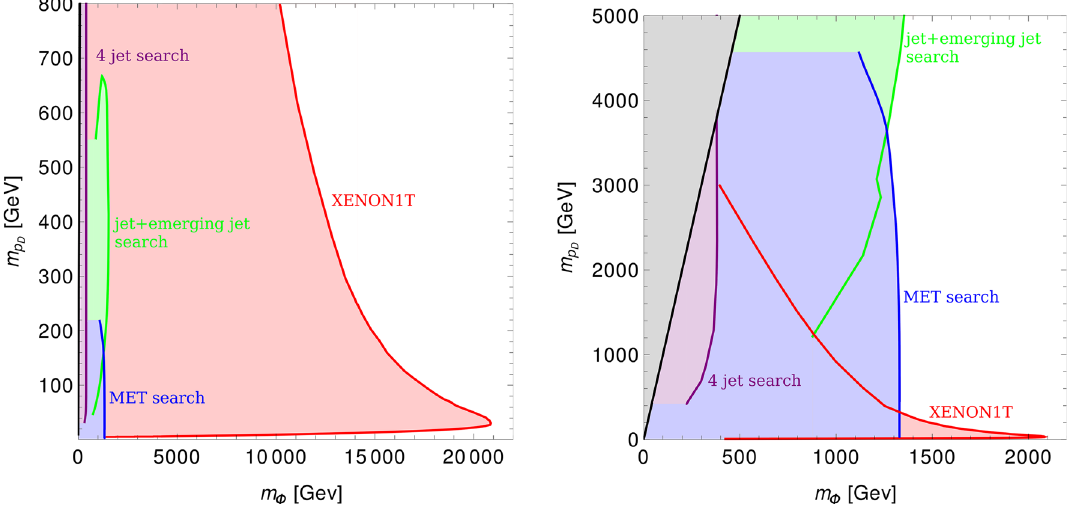
= 10 m π . Left: κ = diag ( 1 , 1 , 1 ) , right: κ = diag ( 0 . 1 , 1 , 1 ) . In the gray D D